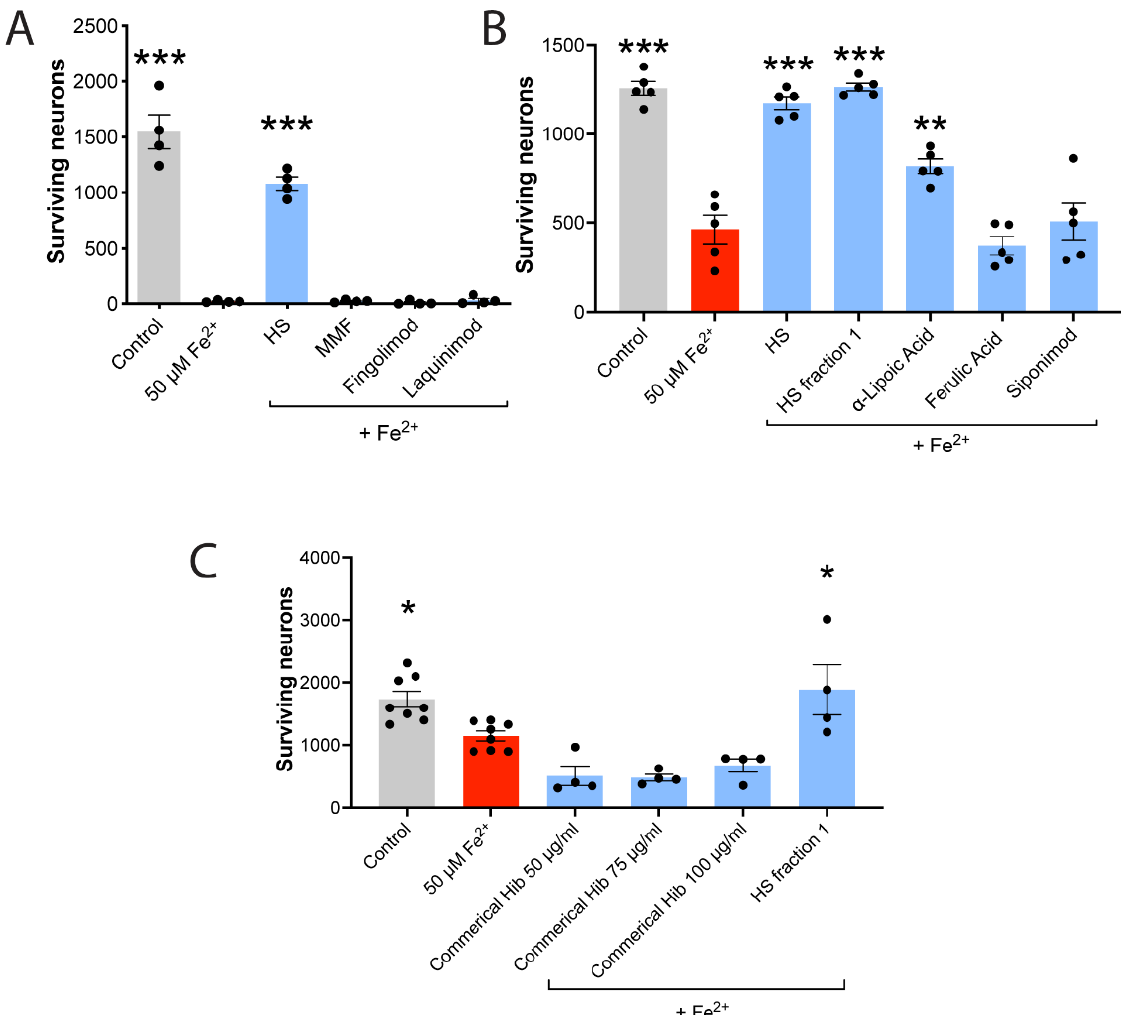
Figure 3. HS protection against iron neurotoxicity is not mimicked by MS medications or a commercial hibiscus extract and is not proportional to anti-oxidant activity. ( A ) The loss of neurons caused by 50 µ M of FeSO 4 is ameliorated by HS (100 µ g/mL) but not by MMF (100 µ M), fingolimod (FTY-720P, 100 nM) or laquinimod (5 µ M). These concentrations of drugs used in MS are congruent with reported concentrations for neuroprotection against other stressors in the literature. ( B ) HS (100 µ g/mL) and its fraction 1 (80 µ g/mL) completely overcome iron toxicity, while the strong anti-oxidant ferulic acid (5 µ g/mL) or the MS medication siponimod (1 nM) are ineffective. *** p < 0.001 (1-way ANOVA with Dunnett multiple comparisons) compared to FeSO 4 . Alpha lipoic acid (50 µ g/mL) partially ameliorates killing of neurons by iron. ( C ) The commercial hibiscus from 50 to 100 µ g/mL does not protect iron neurotoxicity unlike the positive control, HS fraction 1. All values are mean ± SEM, with each dot representing a well. * p < 0.001, ** p < 0.01, *** p < 0.001 (1-way ANOVA with Dunnett multiple comparisons) compared to